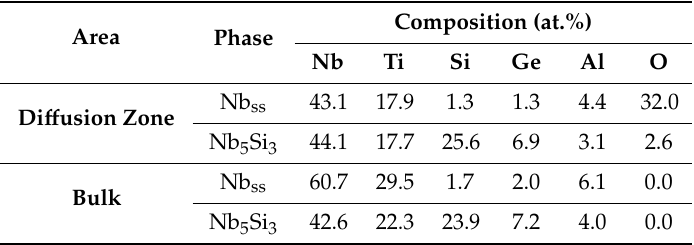
Figure 6. BSE image showing the typical microstructures of a cross-section of the alloy ZF5 after oxidation in air at 800 °C for 100 h.